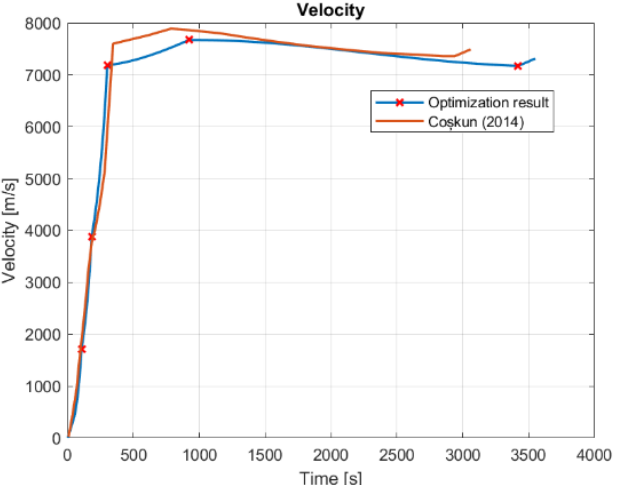
Figure 6. Velocity in the optimized trajectory. The red marks indicate the staging or coasting phase.